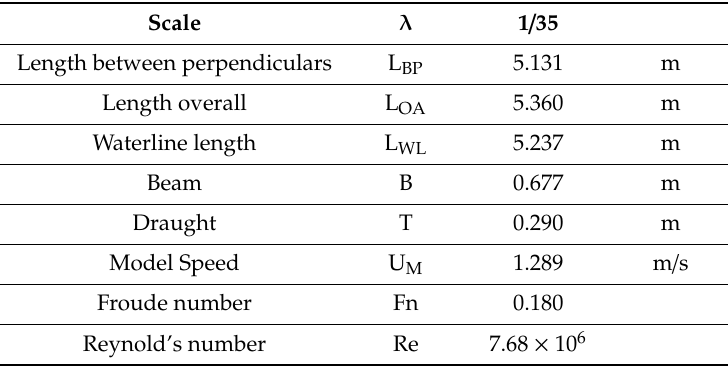
Table 3. Characteristics of the model.